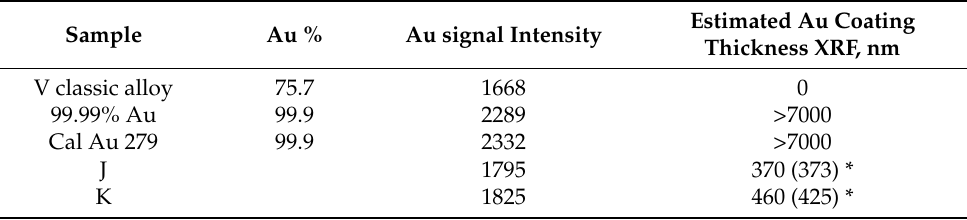
Table 8. Au signal intensity from XRF and estimated Au coating thickness using XRF for reference samples and thicker coatings.